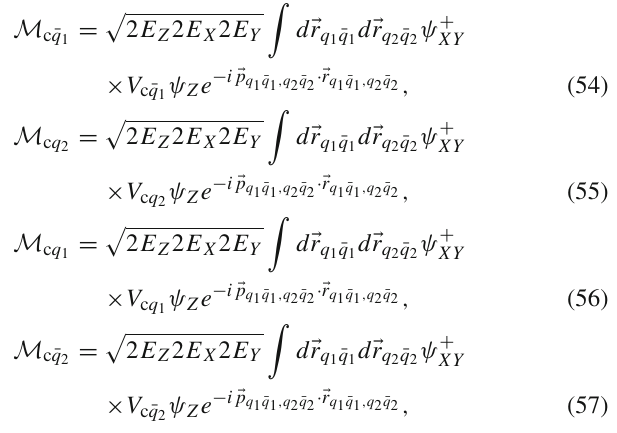
We calculate widths of the ψ( 3770 ) , ψ( 4040 ) , ψ( 4160 ) , and ψ( 4415 ) decays, which produce two charmed mesons or two charmed strange mesons. Four Feynman diagrams at tree level are involved in Z → X + Y , and are shown in Fig. 6. The two upper diagrams correspond to Z ( q 2 ¯ q 1 ) → X ( q 1 ¯ q 1 ) + Y ( q 2 ¯ q 2 ) , and the two lower diagrams Z ( q 1 ¯ q 2 ) → X ( q 1 ¯ q 1 ) + Y ( q 2 ¯ q 2 ) . Denote by ψ Z and ψ XY the mesonic quark–antiquarkwavefunctionsofmeson Z andofmesons X and Y , respectively. Let ( E X , (cid:4) p X ) , ( E Y , (cid:4) p Y ) , and ( E Z , (cid:4) p Z ) be the four-momenta of mesons X , Y , and Z , respectively. The transition amplitudes corresponding to the left upper dia- gram, the right upper diagram, the left lower diagram, and the right lower diagram are given by